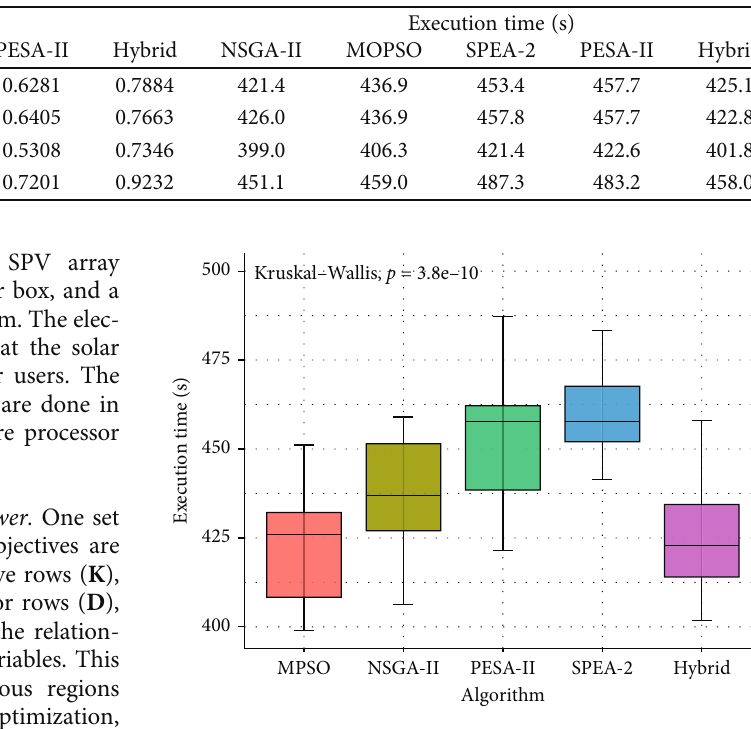
Figure 20: Comparison of algorithms by execution time.